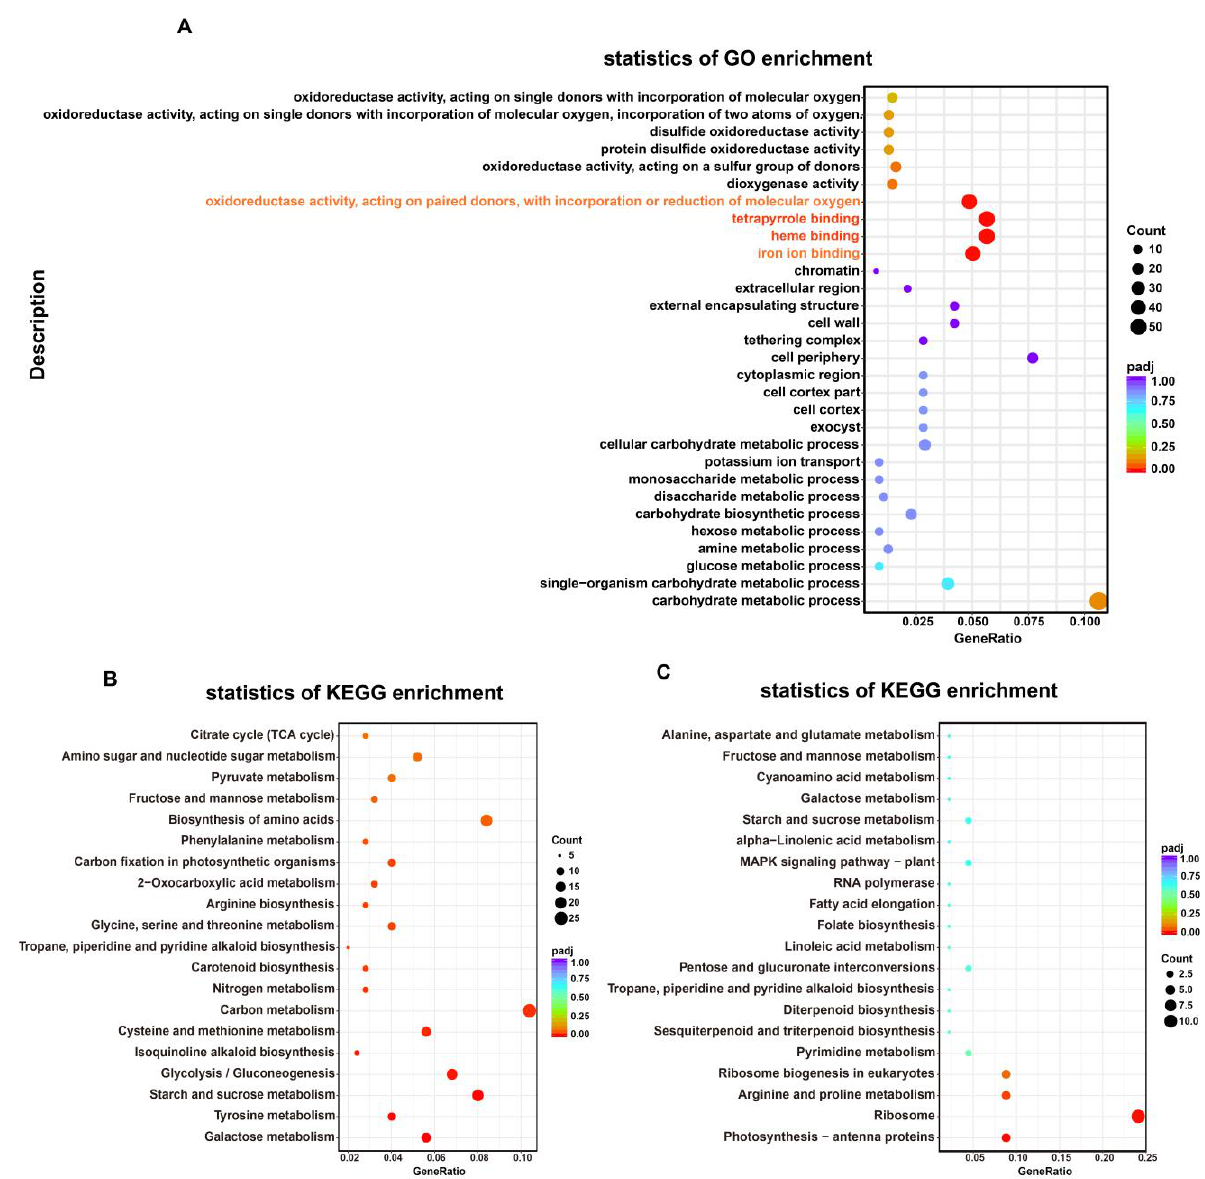
Figure 4. Functional annotation and classification of DEGs identified in MT vs. WT transcriptome, as determined using the GO and KEGG databases. ( A ) GO enrichment analysis; ( B ) KEGG enrichment analysis of up-regulated DEGs; ( C ) KEGG enrichment analysis of down-regulated DEGs. GeneRatio, the ratio between DEGs annotated to a particular KEGG pathway/GO term and all DEGs annotated to KEGG pathway/GO category; padj, p -values corrected for multiple hypothesis testing, a lower padj indicates more significant enrichment of the DEGs; count, the number of DEGs annotated to KEGG pathway/GO term. All the analyses used WT as a control.